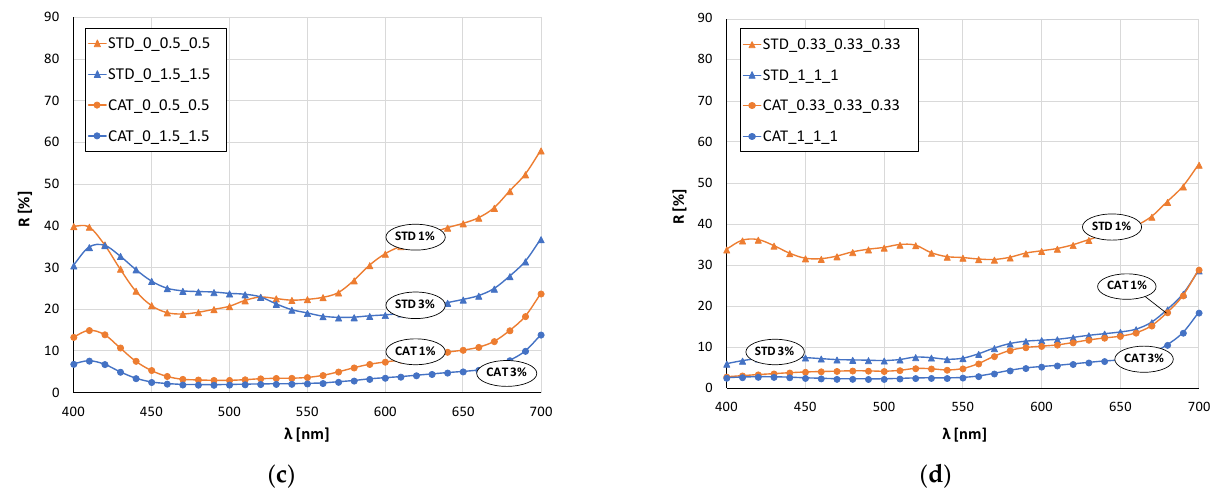
Figure 4. Remission curves of standard and cationized fabrics dyed with 1 and 3% owf mixture of dye: ( a ) yellow and red, ( b ) yellow and blue, ( c ) red and blue, ( d ) yellow, red and blue.